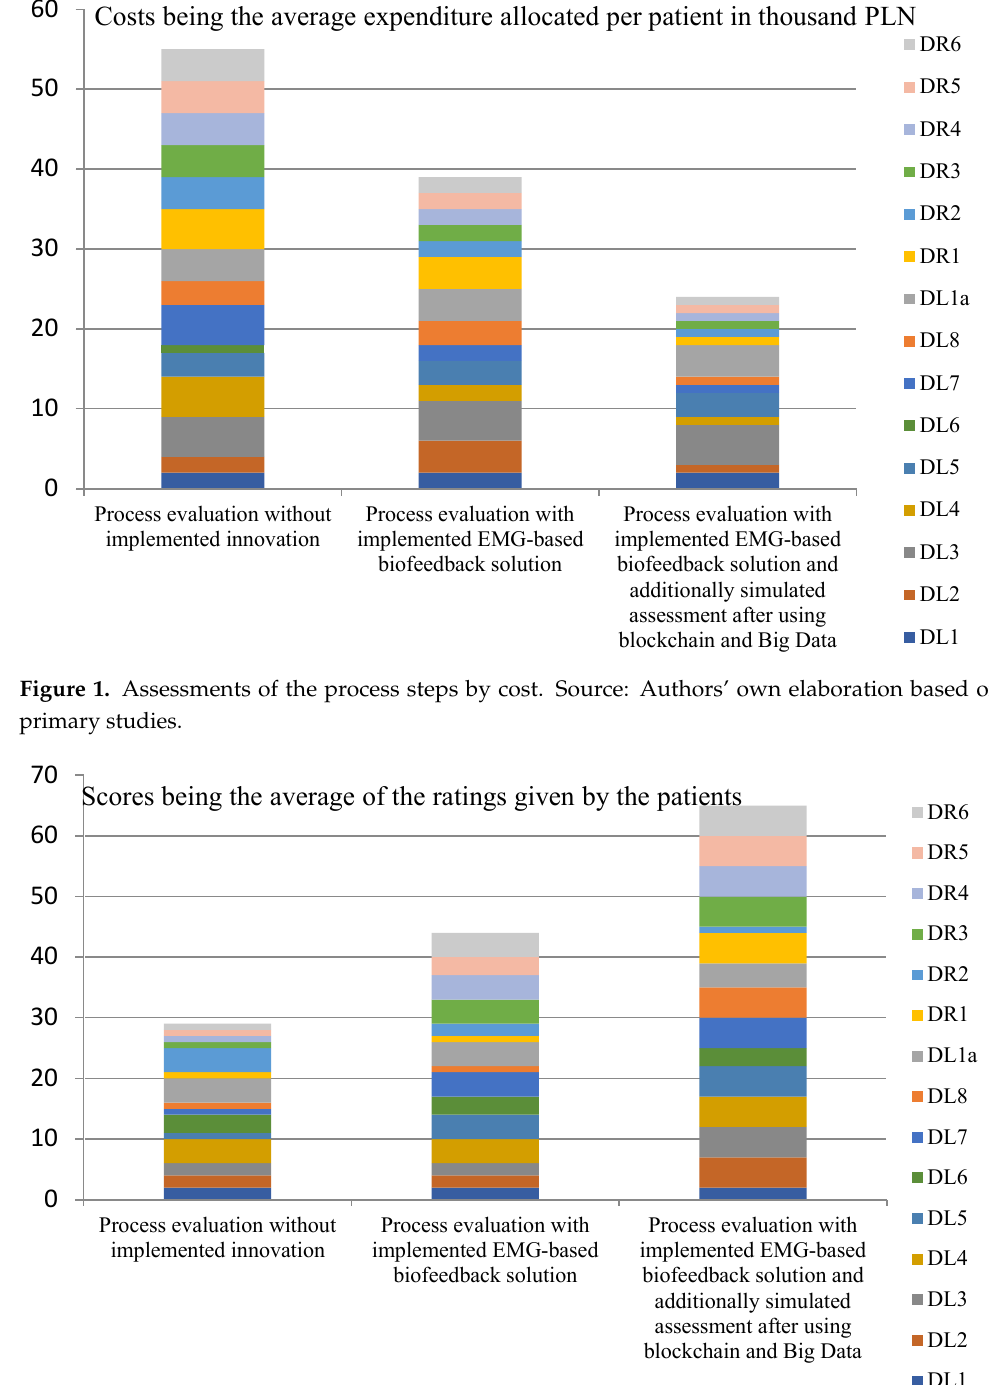
Figure 2. Assessments of the process steps in terms of the creation of values for the patient’s physical health. Source: Authors’ own elaboration based on primary studies.